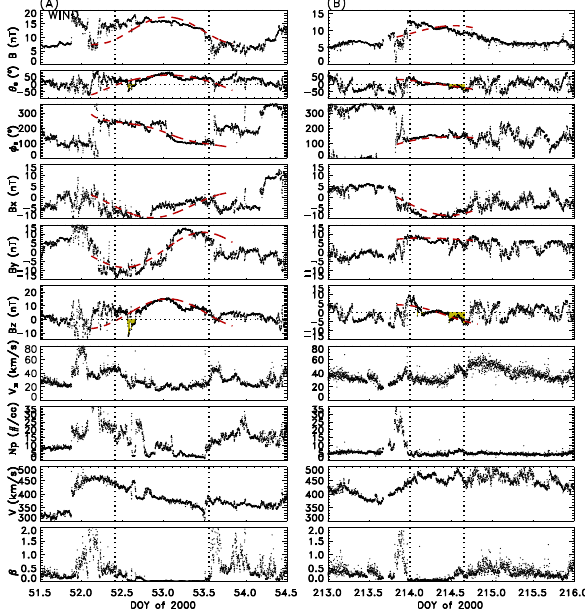
Fig. 7. Two examples of poor quality (Q 0 =3)MCs, both from the year 2000: (A) the event of 21–22 February Days 52 and 53 and (B) that of 1 August Day 214, presented in the same format as that of Fig. 1. In the first one (A) the quality is poor, because of the poor parameter fit, where χ R was high, 0.215, and in the second one (B) χ R was acceptable (0.122), but the asymmetry factor (asf) was large, 45.9%, i.e. the peak in B MODEL is far off center (and notice that there was little change in the latitude of the field within this MC making MC parameter fitting difficult). The regions shaded in yellow in both cases are where the observed B z components are briefly